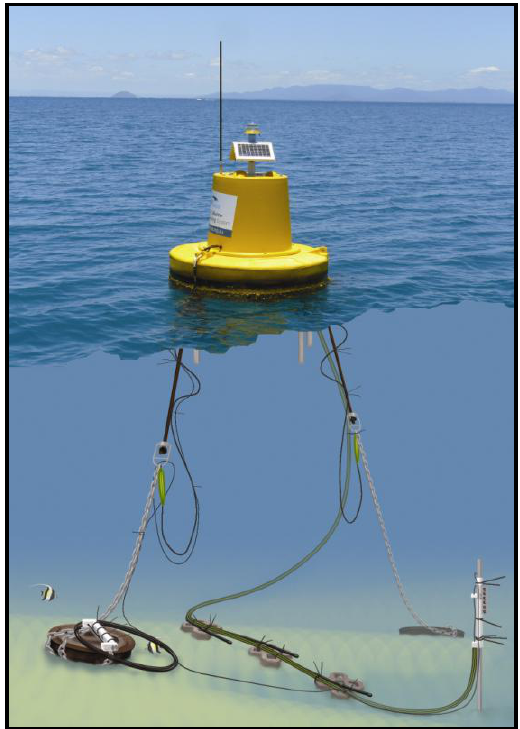
Figure 4. Typical deployment of a sensor-buoy showing the two-point mooring